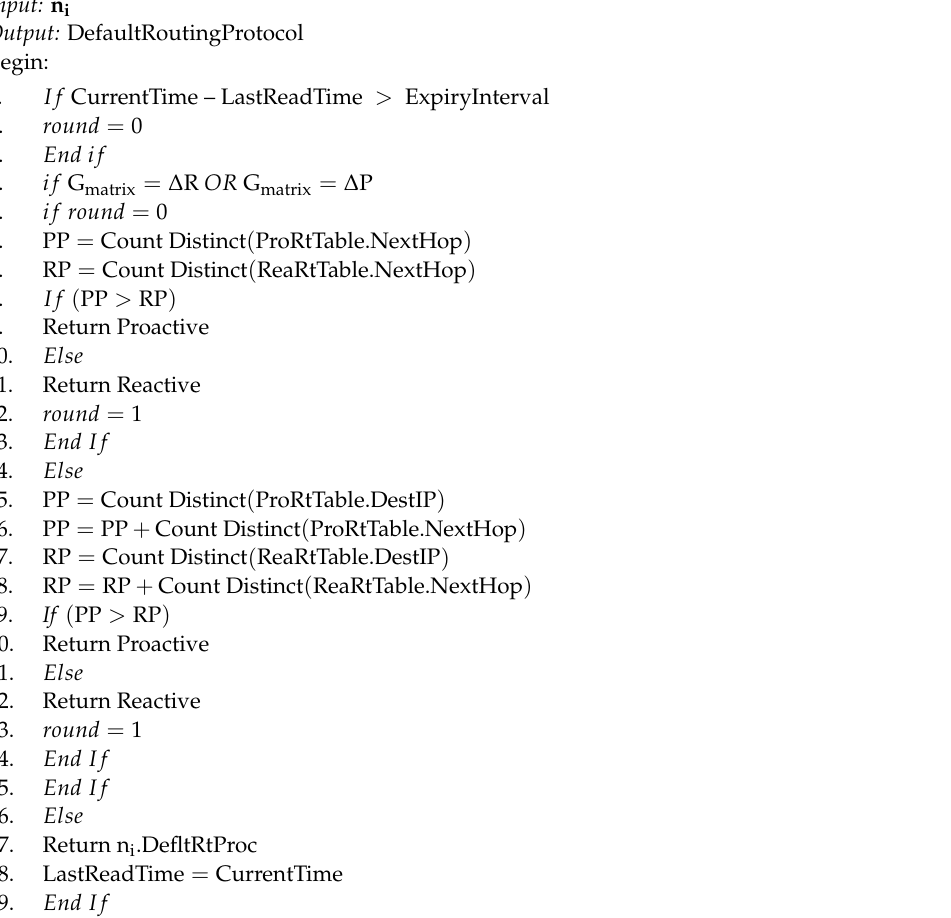
Algorithm 2: Evolution Process for Default Routing